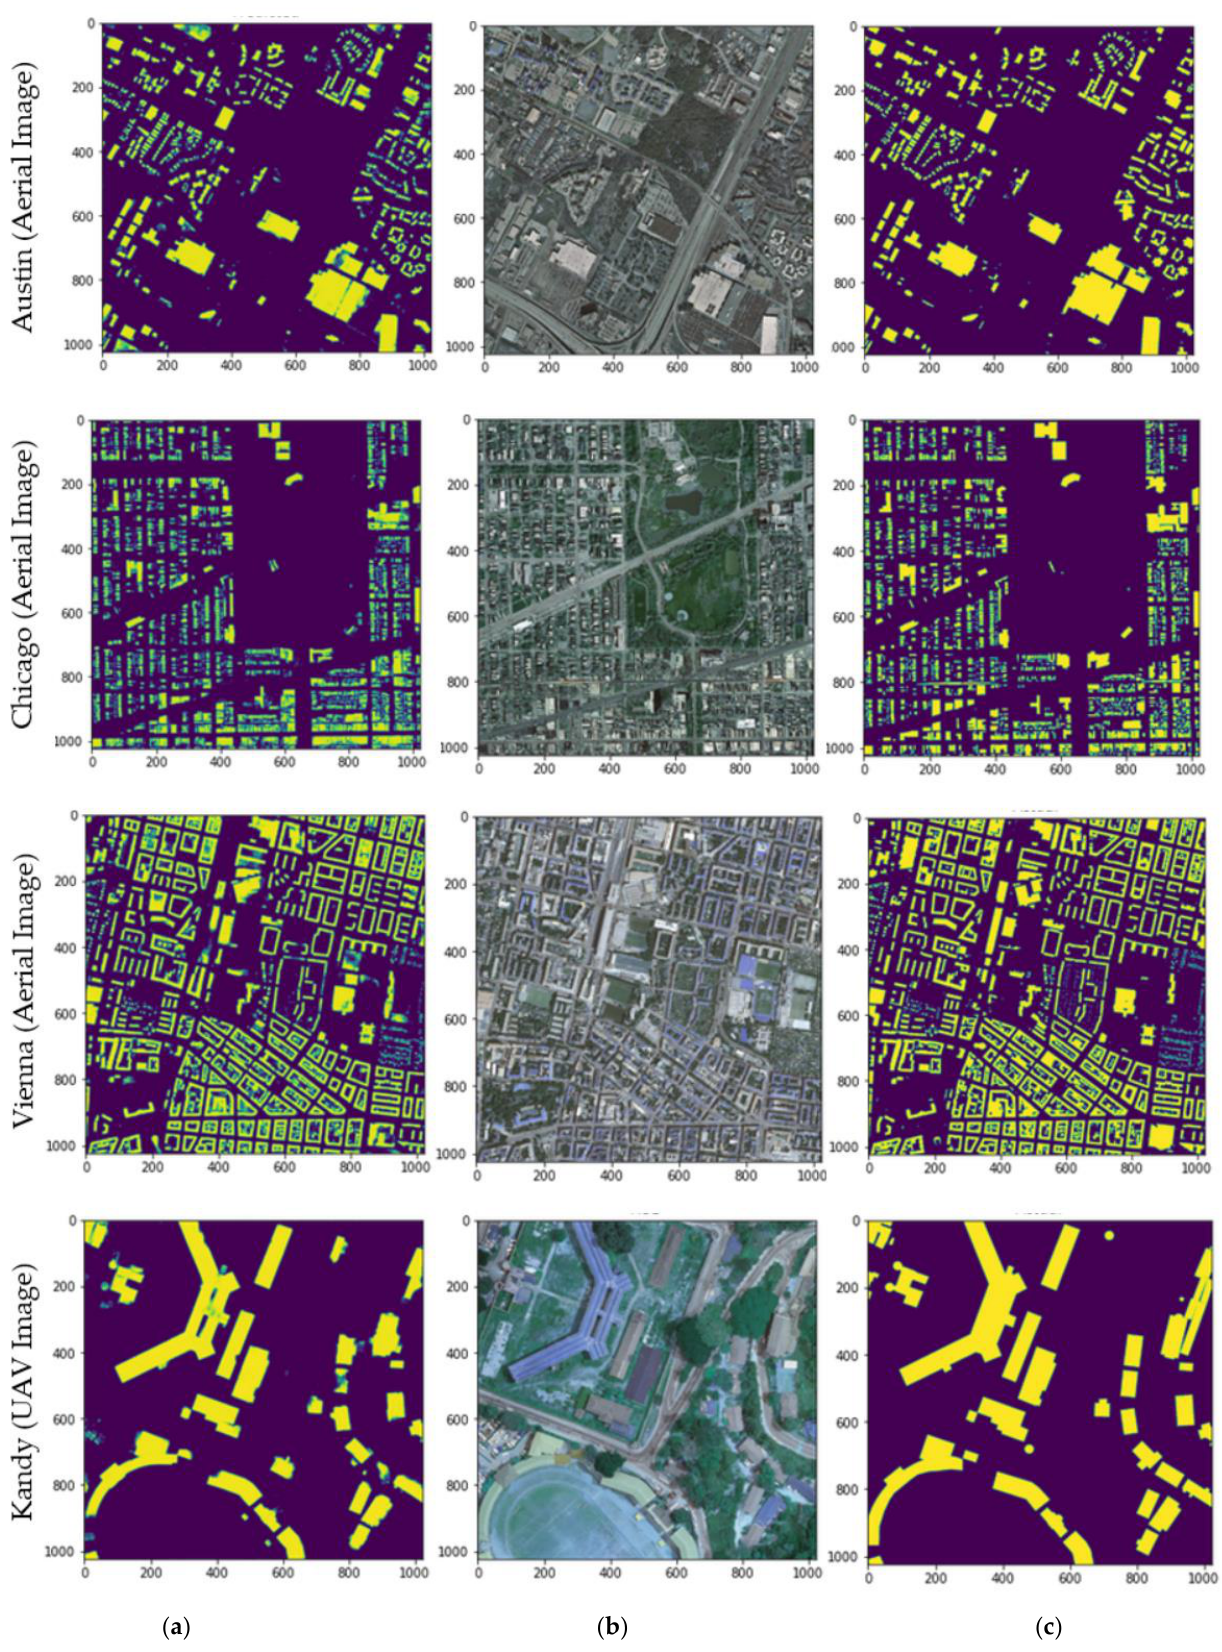
Figure 8. Building detection results from the developed DL network for the four cities (( a ): results from the model, ( b ): RGB images, ( c ): ground truth data).